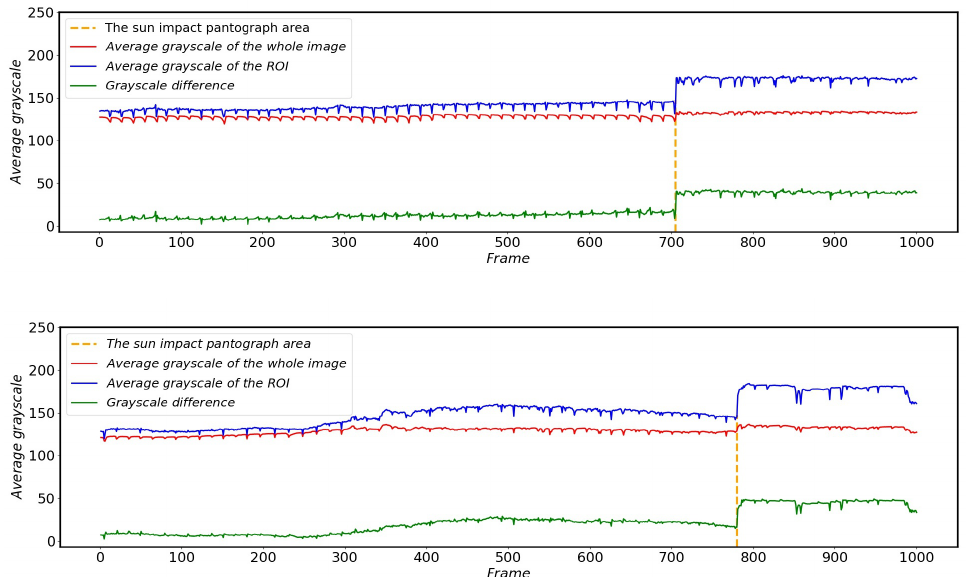
Figure 19. Average grayscale variation in the corresponding areas of HSR-A ( top ) and HSR-B ( bottom ) during sun influence pantograph detection.